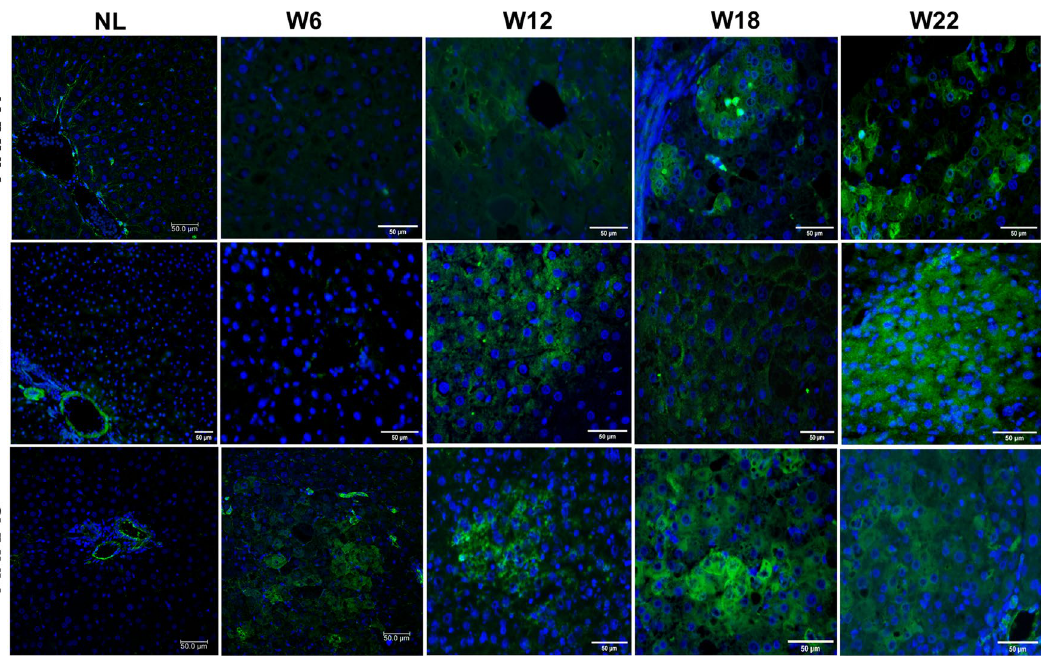
Figure 3. Increased annexins in cells of nodules during hepatocarcinogenesis. Representative images of ANXA1, ANXA2, and ANXA5 expression in NL tissue, preneoplastic lesions (W6 and W12), and HCC tumor cells (W18 and W22) were obtained by IF analysis. Annexin proteins were labeled with Alexa Fluor 488 (green), while nuclei were stained with DAPI (blue). Magnification: 400X. Scale bar = 50 μm. n = 5 animals/group. Images were captured with ZEISS Axio-A1